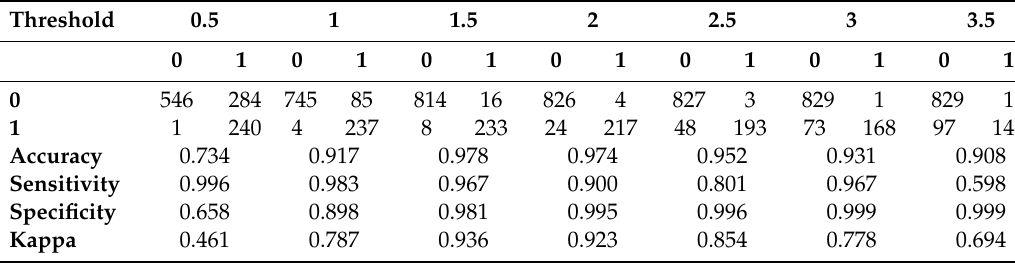
Table A1. Classification matrix and accuracy results for demolished / non-demolished buildings for various thresholds of the di ff erence between the mean heights of the two-point clouds. Columns are those modelled, and rows are the actual values (number of